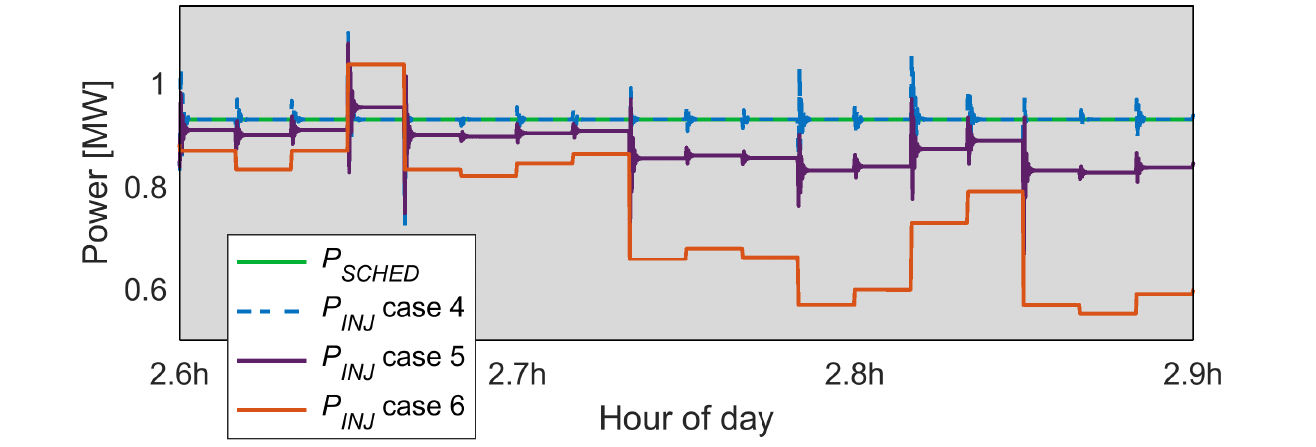
Figure 28. Zoom Scenario 2: Injected power and tolerated band/injection